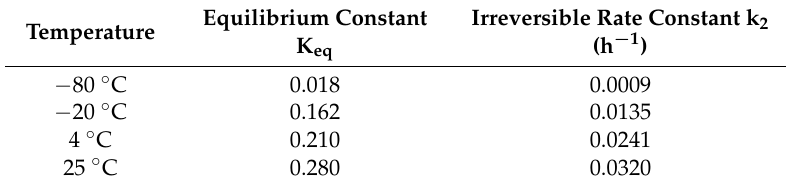
Table 2. Kinetic constants for the Equilibrium-Irreversible reaction model of CA